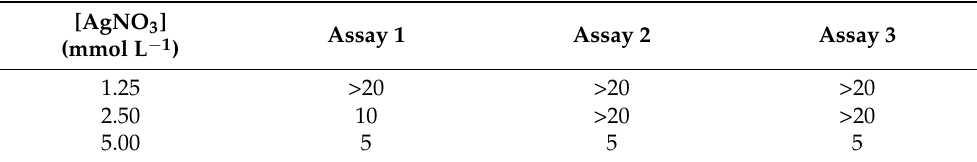
Table 1. CFU count in inhibition halos formed by AgNPs synthesized at pH 10.0 in Petri dishes inoculated with Escherichia coli .